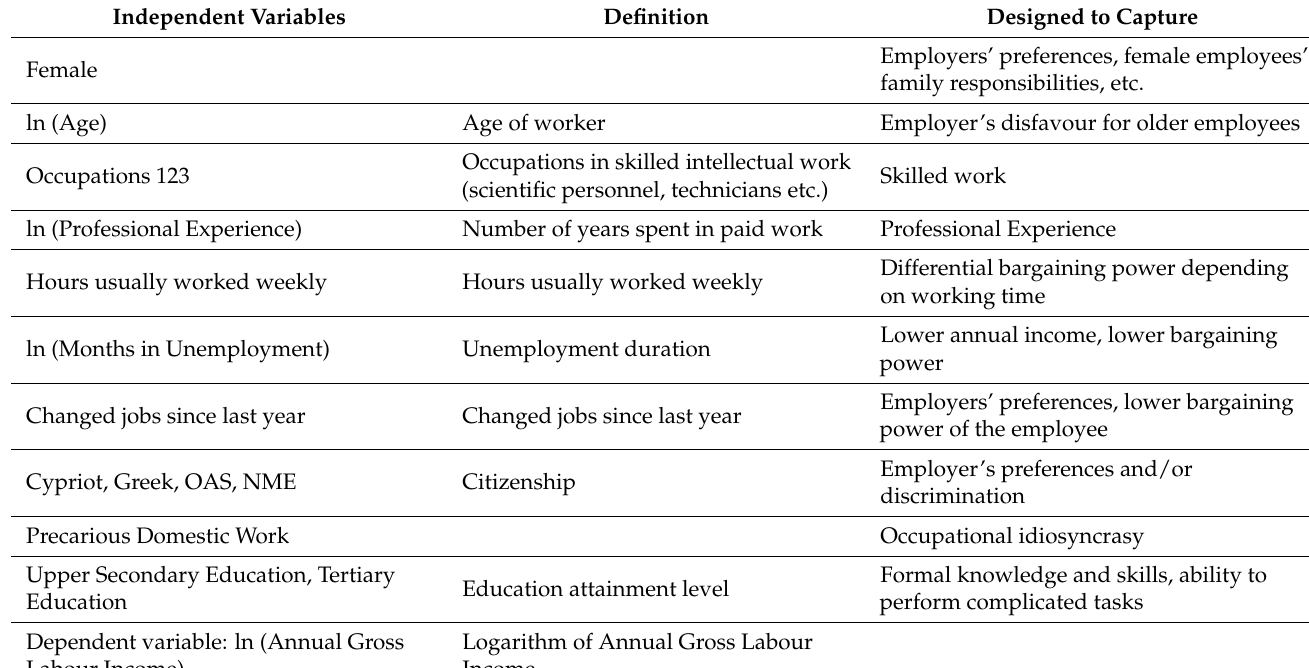
Table 2. Definition of variables of linear regression for the determination of factors affecting labour income of the